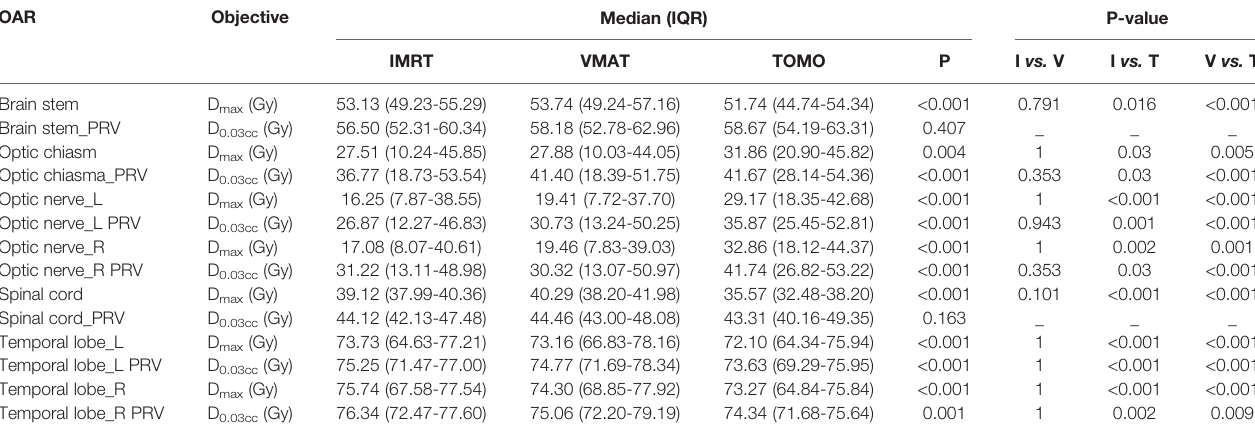
TABLE 3 | Dosimetric comparison of IMRT, VMAT and TOMO for organs at risk (priority level I and II) in 40 NPC